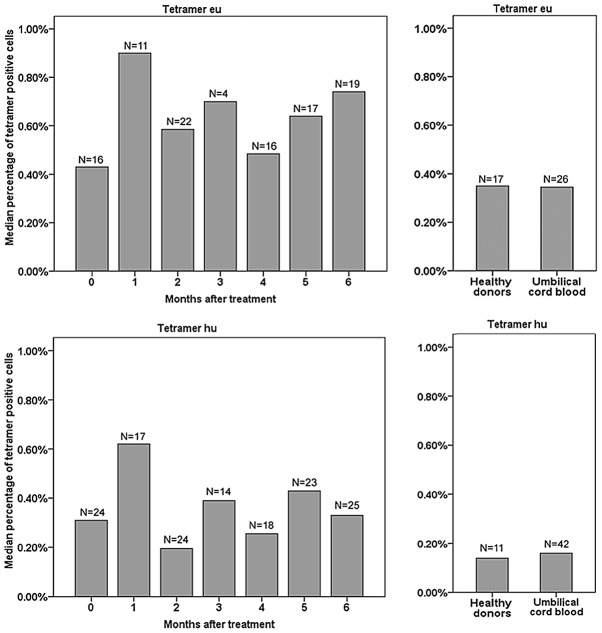
Percentage changes in tetramer-bound CD14+ monocytes in PTB outpatients in the continuous treatment group.PBL samples from 7 continuous time point-racked PTB outpatients, including patients who had not received treatment and those who received 6 months of regular anti-TB treatment, were stained with the eu- or hu-tetramer and analyzed using flow cytometry. N indicates the sample size of each group. After a month of treatment, there were statistical differences in terms of the percentages of tetramer-positive cells between PTB patients and both the healthy donors and umbilical cord blood groups (according to the results of the Mann-Whitney U test: 0.86%, 0.35% and 0.14%, p<0.001 and p<0.009 for eu-tetramer staining, respectively; and 0.62%, 0.14% and 0.16%, p<0.000 and p<0.000 for hu-tetramer staining, respectively). There was no significant difference between PTB patients at the indicated month after treatment in terms of the results of either tetramer staining according to the result of the Kruskal-Wallis H test (p = 0.585 and p = 0.141, respectively).